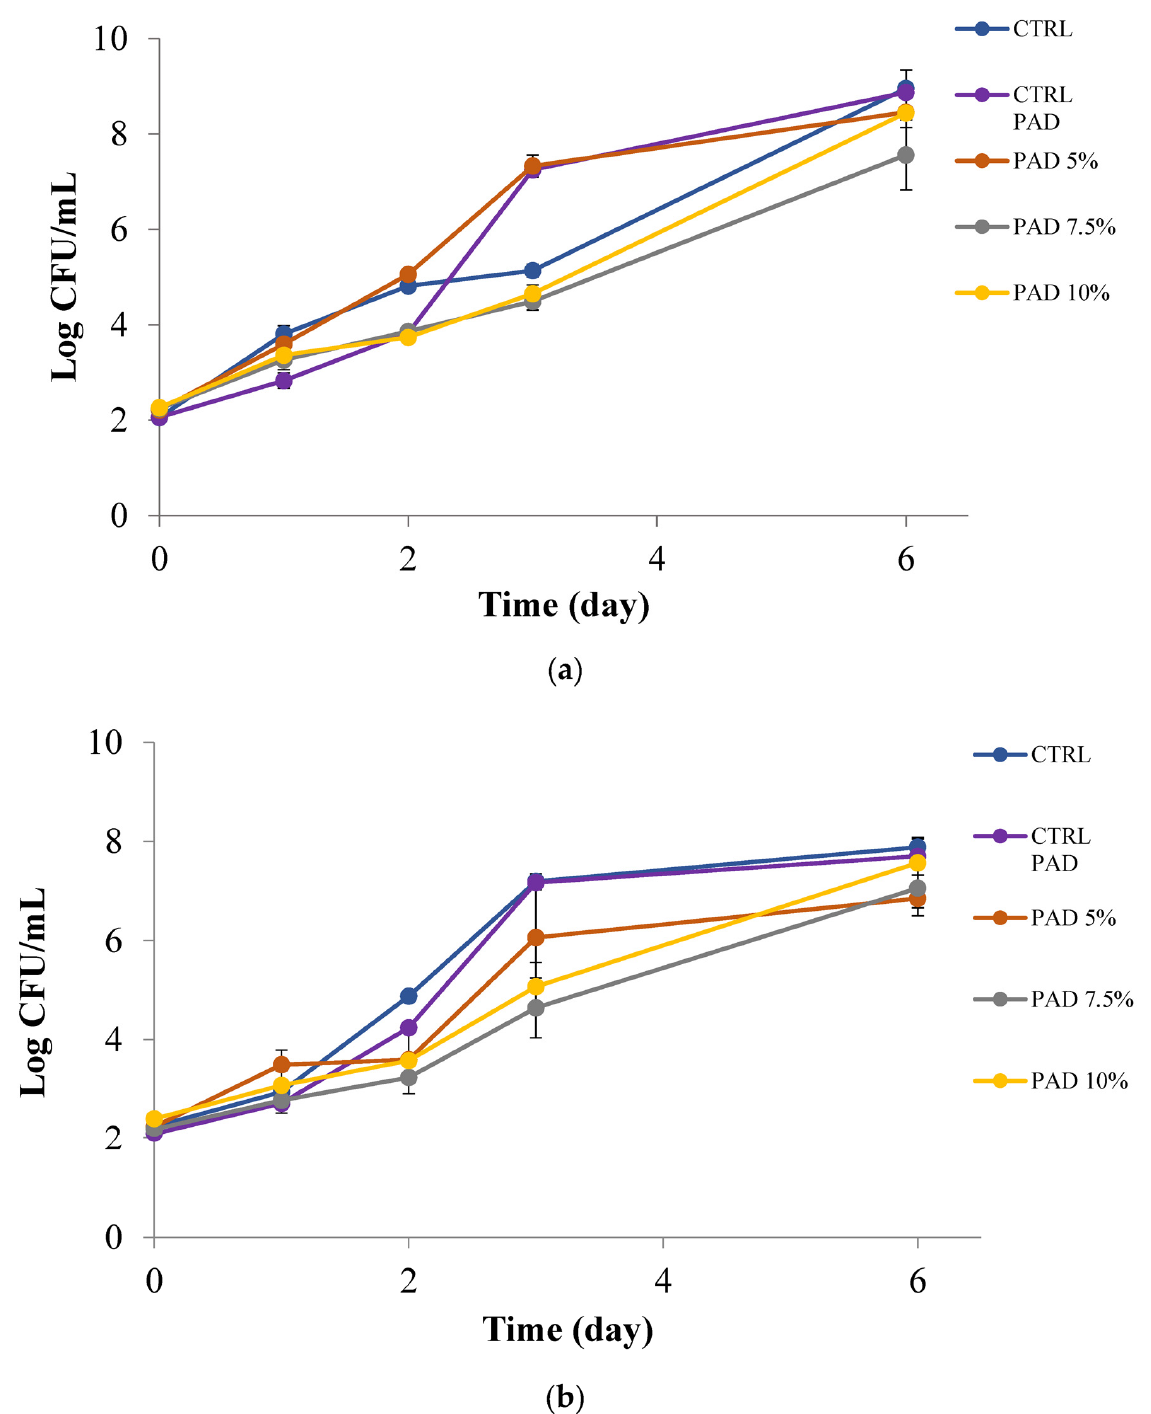
Figure 6. Pseudomonas spp. ( a ) and yeasts ( b ) in soymilk with and without pads at 0, 5, 7.5 and 10% ( w / v ). ( w / v